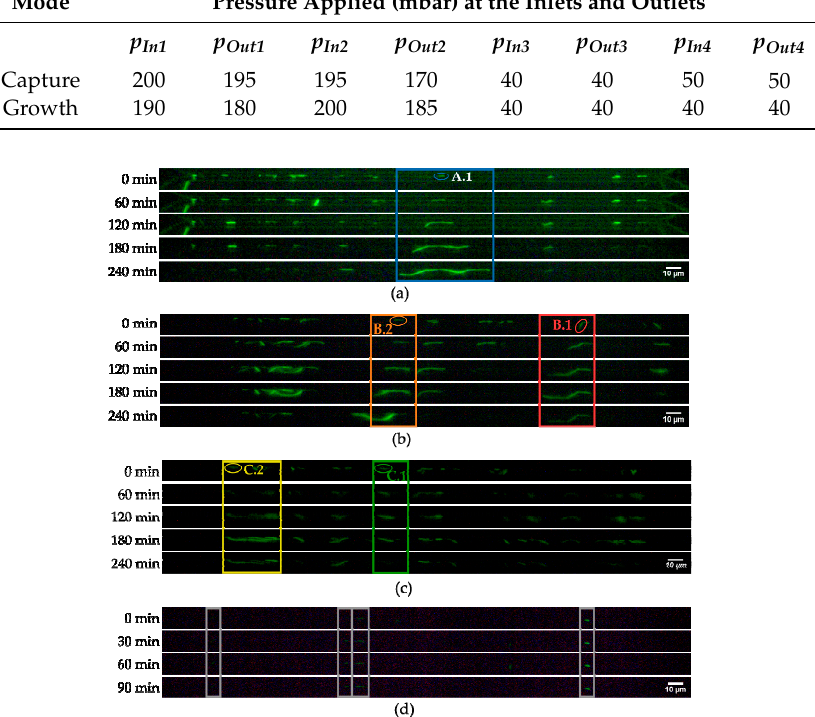
Figure 6. Fluorescent microscope images (20× magnification) showing E. coli immobilized at the nanogap at 37 °C with Terrific Broth (TB) medium flowing through the detection channel over 4 hours. ( a – c ) Three exemplary growth experiments designated A, B, and C. Measured cells are numbered within each experiment. ( d ) Negative control with addition of antibiotics (200 µg/mL kanamycin). Marked are measured cells.